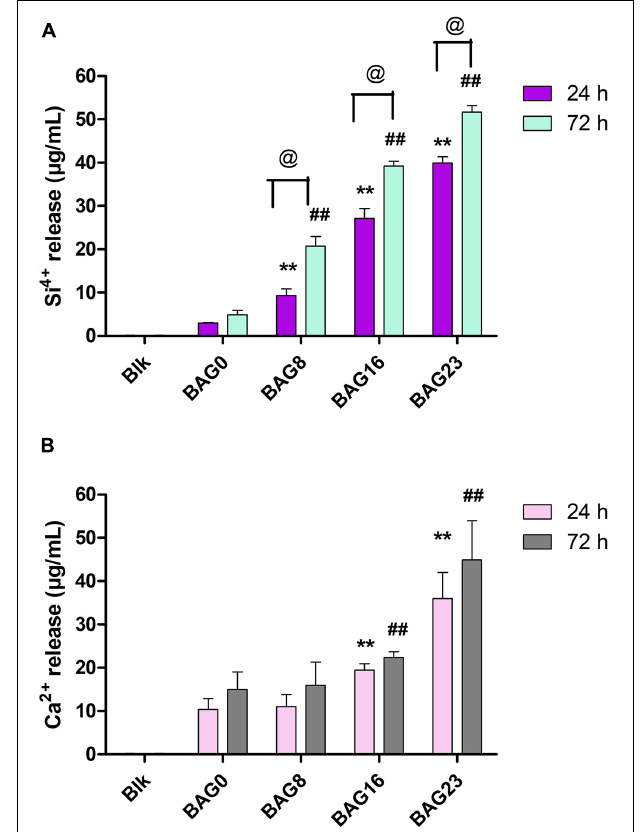
FIGURE 7 | The concentration of Si 4 + and Ca 2 + in the BHI extracts of BAG-modified composite resin measured by inductively coupled plasma mass spectrometry (ICP-MS). (A) Si 4 + release. (B) Ca 2 + release. Blk: BHI as blank control; BAG0 indicates composite resin without BAG; BAG8 indicates composite resin with 8 wt% BAG; BAG16 indicates composite resin with 16 wt% BAG; BAG23 indicates composite resin with 23 wt% BAG. ** p < 0.01 vs. the 24 h extracts of BAG0 group, ## p < 0.01 vs. the 72 h extracts of BAG0 group, @ p < 0.05 significant difference as compared